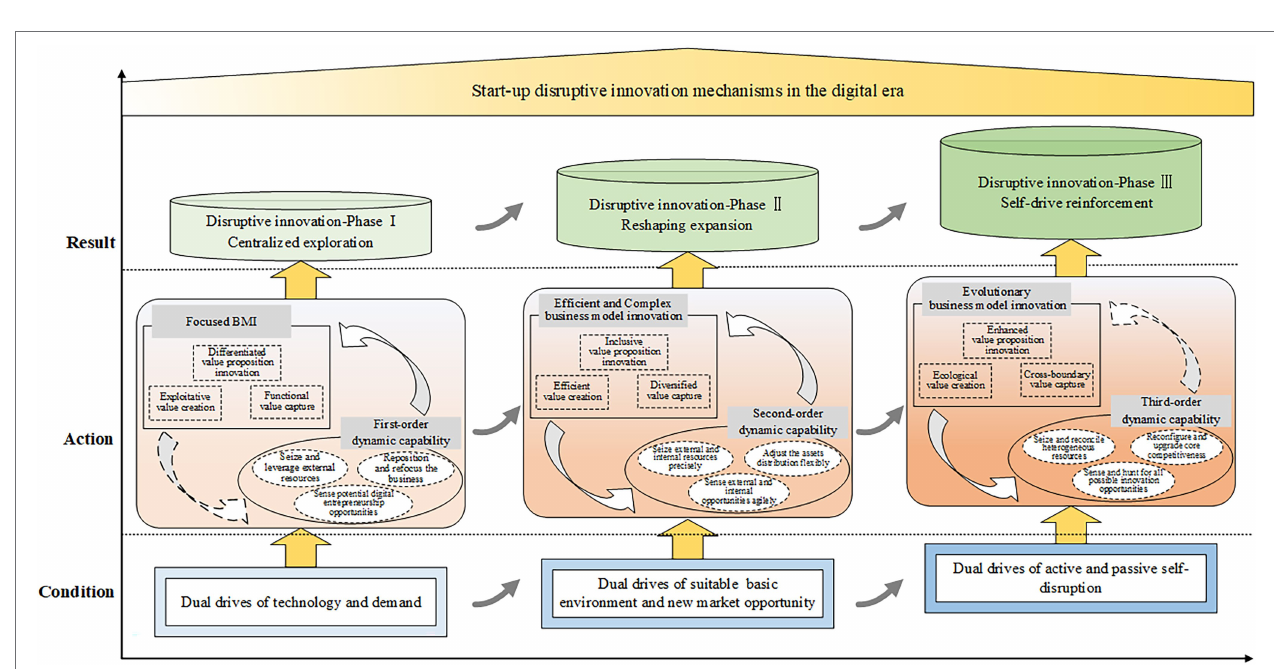
FIGURE 4 | The evolution mechanism of start-up disruptive innovation in the digital